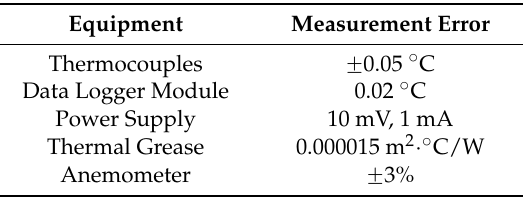
Table 2. Experimental